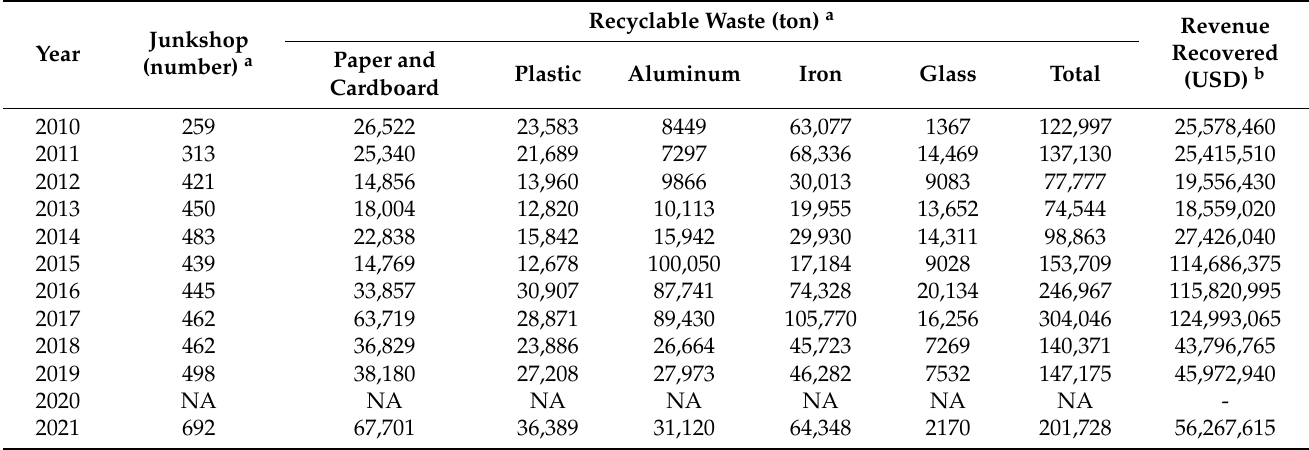
Table 4. Recyclable waste purchased by junkshops from 2010 to